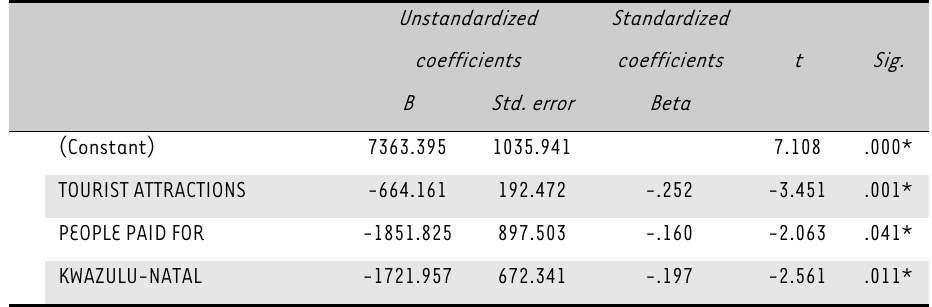
Results from the backward linear regression: determinants of participant spending for the ‘down’ run Unstandardized coefficients